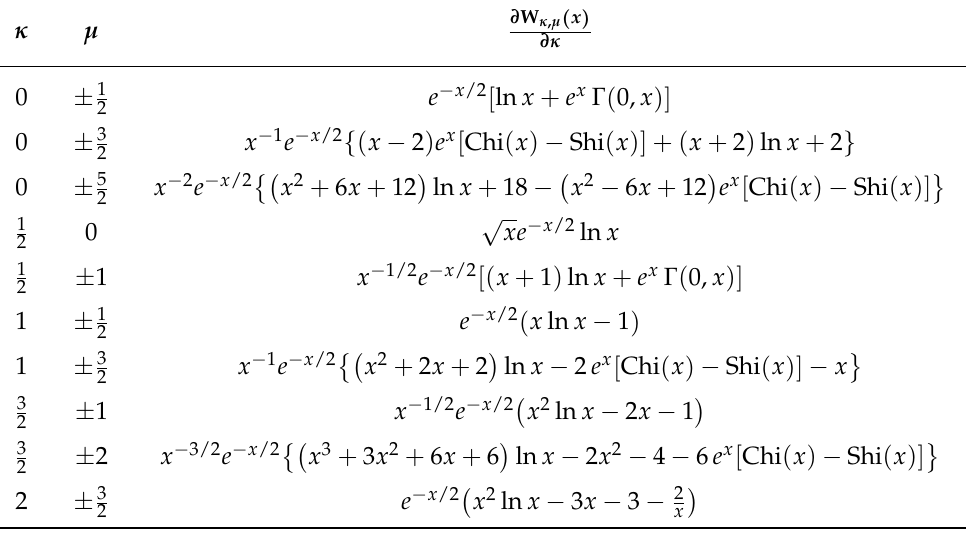
Table 6. First derivative of W κ , µ ( x ) with respect to parameter κ for particular values of κ and µ